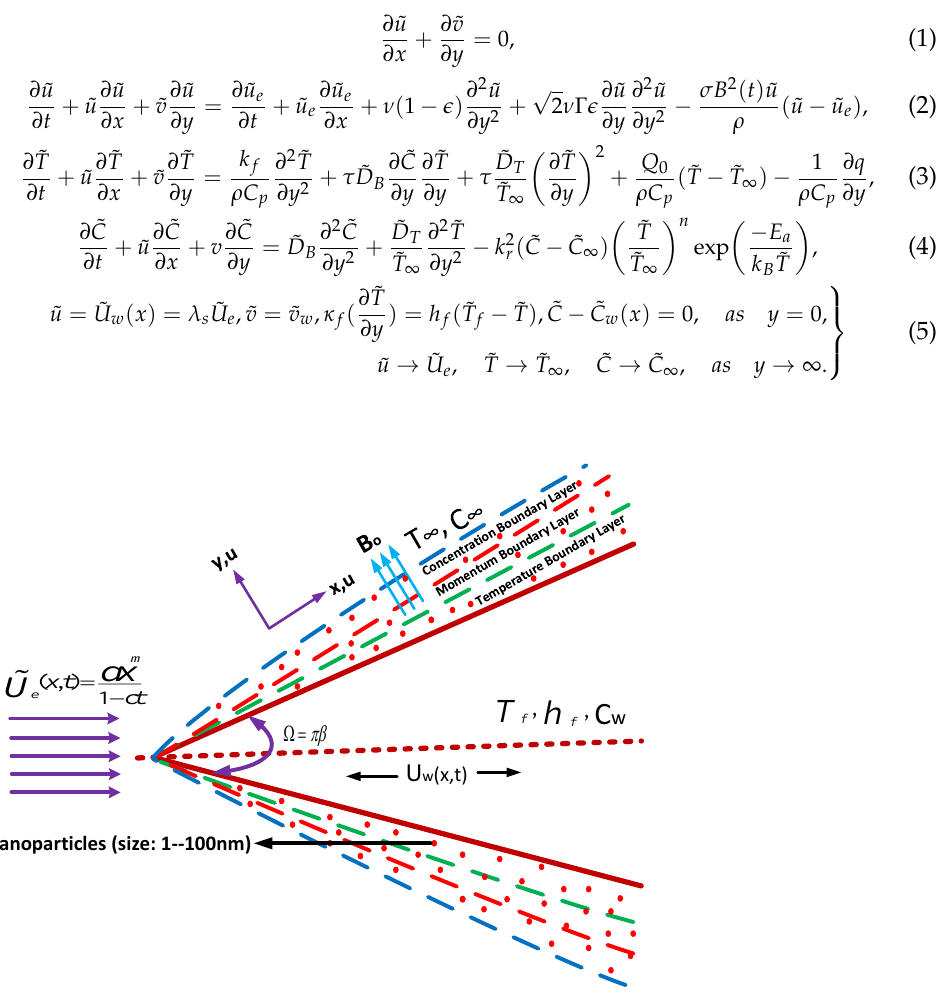
Figure 1. Physical and schematic configuration with coordinate system. Here, ( ˜ u , ˜ v ) are velocity component in x , y directions, respectively, ˜ T and ˜ C are the fluid temperature and nanoparticle volume concentration, ˜ D B and ˜ D T are the Brownian diffusion and thermophoretic diffusion coefficient respectively, ˜ U e is the free stream velocity, B 0 , m , ρ , C p , E a , (cid:101) , and Γ are the uniform magnetic field strength, Falkner–Skan power law parameter, fluid density, specific heat capacity, activation energy, the power law index, and Williamson parameter, respectively, Q 0 denotes the temperature-dependent volumetric rate α ∗ ∂ ˜ T 4 of heat source ( Q 0 > 0) and heat sink ( Q 0 < 0), q r is given by q r = 4 (see[34,43]), here K 1 3 ∂ y 2 Stefan Boltzman constant is α ∗ and K 1 is the Roseland mean absorption coefficient, Further, ( ˜ C − ˜ C ∞ )( ˜ T ) n exp ( − E a ) shows the modified Arrhenius the last term in Equation (4), k 2 r ˜ T ∞ k B ˜ T equation with a reaction rate of k 2 . Where ˜ T w and ˜ C w are temperature and nanoparticle r volume fraction at the surface. The corresponding ambient values are denoted by ˜ T ∞ , ˜ C ∞